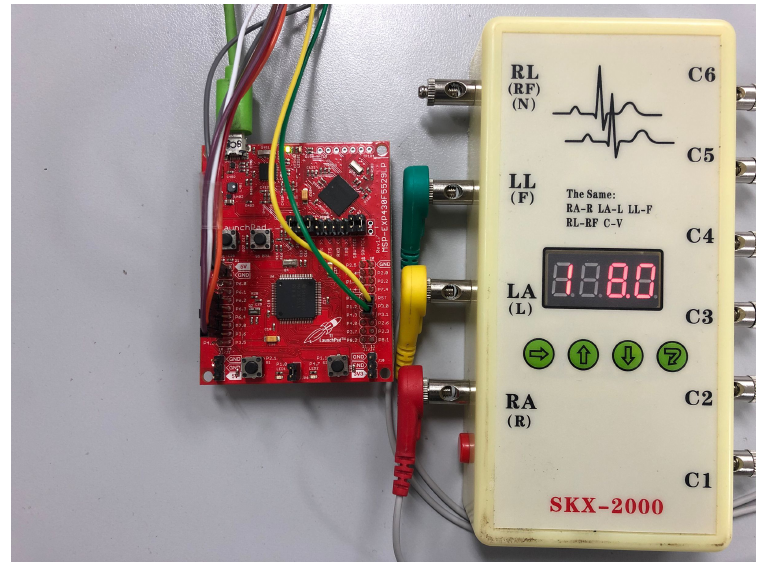
Figure 8. The output heart rate of the ECG simulator is 40 BPM, which simulates the condition of a low heart rate, and the system LED lights up as an alarm.